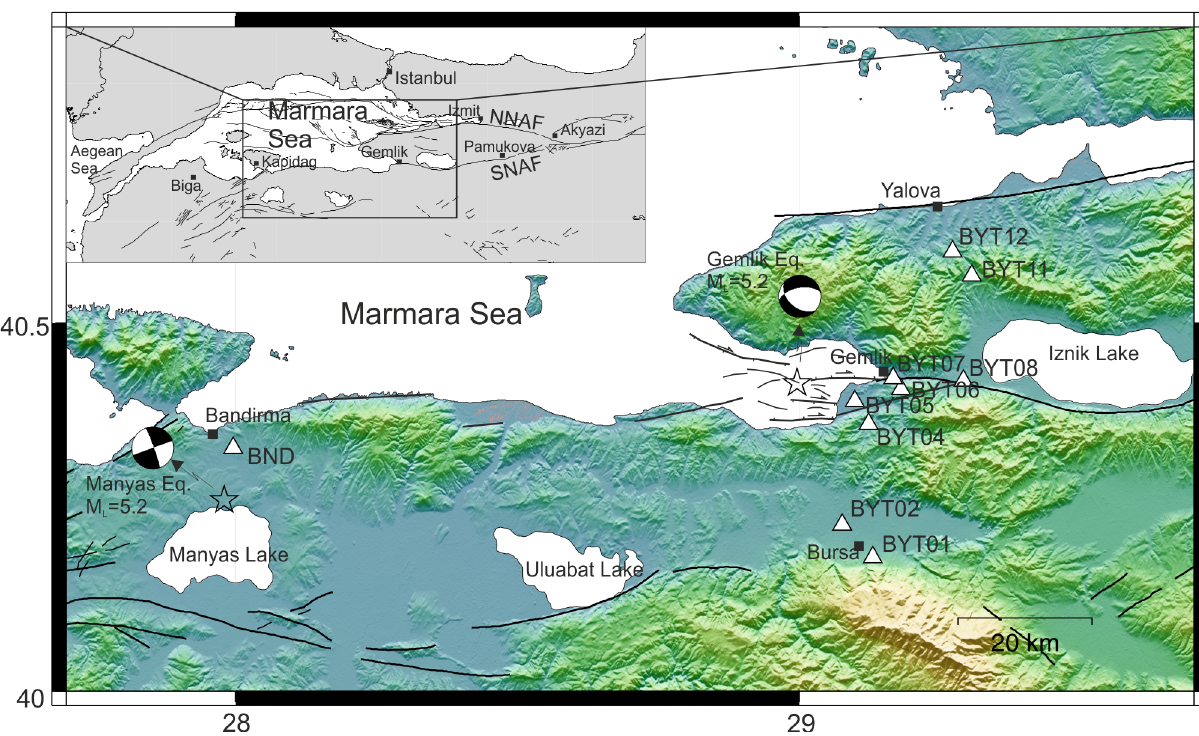
Figure 1. Tectonics of the region (the fault lines are modified from Kuscu et al. [2009], Saroglu et al. [1992] and Le Pichon et al. [2001]) and the locations (stars) of Manyas and Gemlik earthquakes are shown. Source mechanisms of the earthquakes are from Orgulu [2011]. The sta- tions are shown with